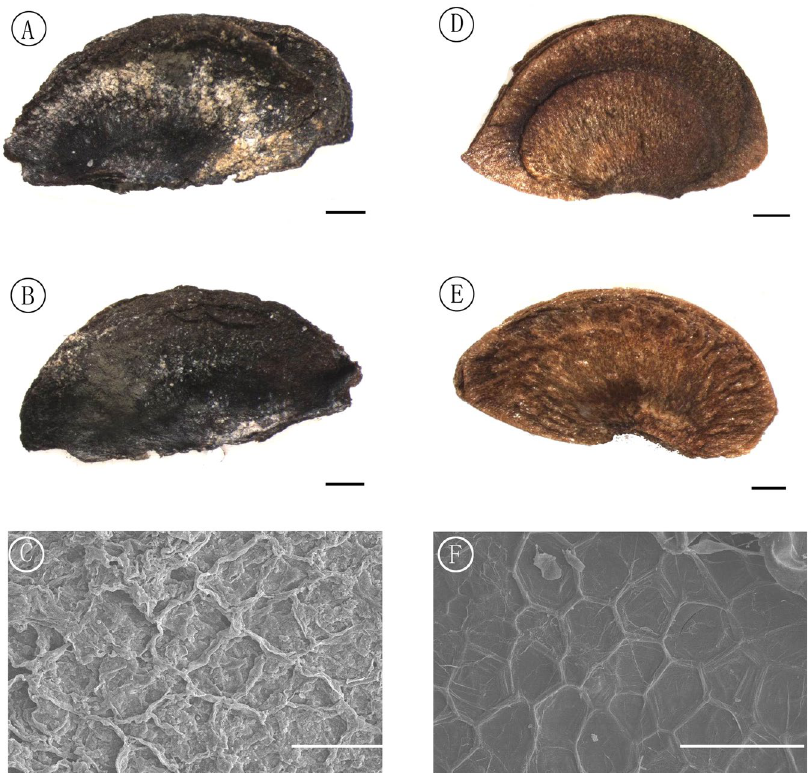
Figure 5. Seed and seed coat structures of Schima kwangsiensis sp. nov. and extant Schima superba . ( A,B ) The two sides of a reniform fossil seed and its wing, specimen number NNF-076. Scale bar = 1 mm. (C) Details of the seed coat structure of A, showing irregular reticulate epidermal ornamentation, Scale bar = 100 μ m. (D,E) The two sides of a modern seed of the species Schima superba , Scale bar = 1 mm. (F) Details of the seed coat structure of D, showing regular reticulate epidermal ornamentation, Scale bar = 100 μ m. Processed and drawn by X. G. Shi using Adobe Photoshop